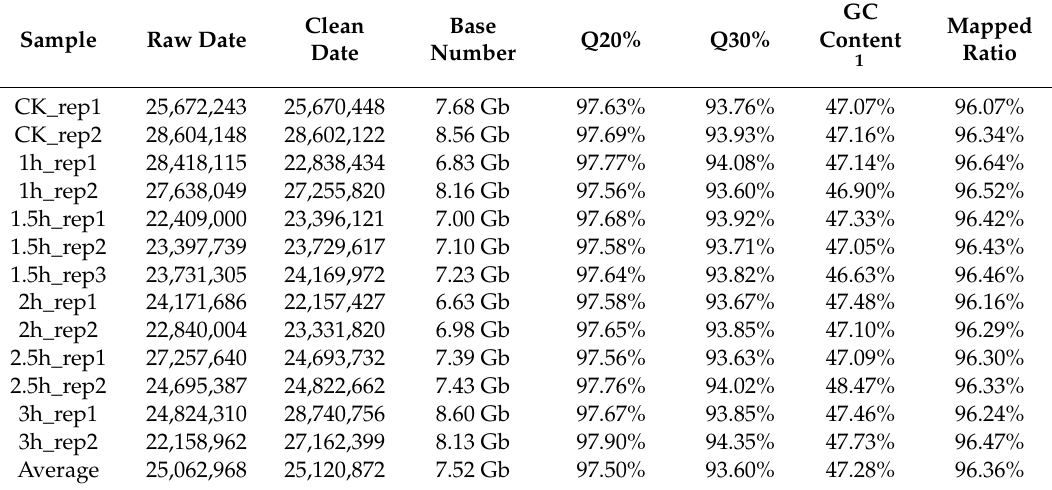
Table A2. Statistics of sequencing data.